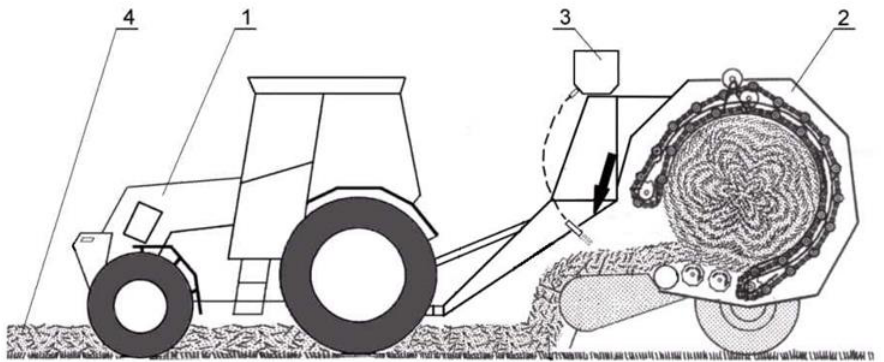
Figure 2. Location of the Junkkari HP 5 applicator spray nozzles on the Vicon RF 122 Opticut round baler. 1, tractor; 2, round baler; 3, applicator; 4, green forage crop. The arrow shows the applicator spray nozzles located above the press pickup.